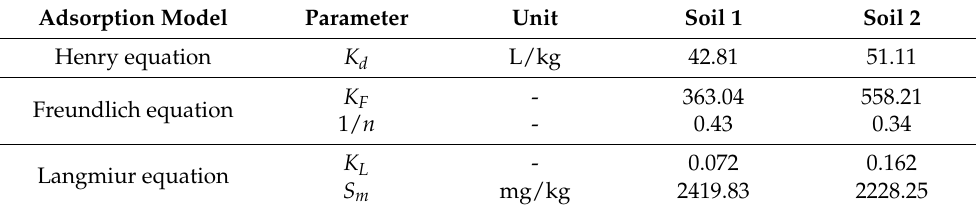
Figure 3. Cadmium adsorption isothermal curves for the two soils are shown in ( A ) Henry equation; ( B ) Freundlich equation; and ( C ) Langmiur equation. Table 2. Isothermal adsorption parameters of cadmium in the two soils.